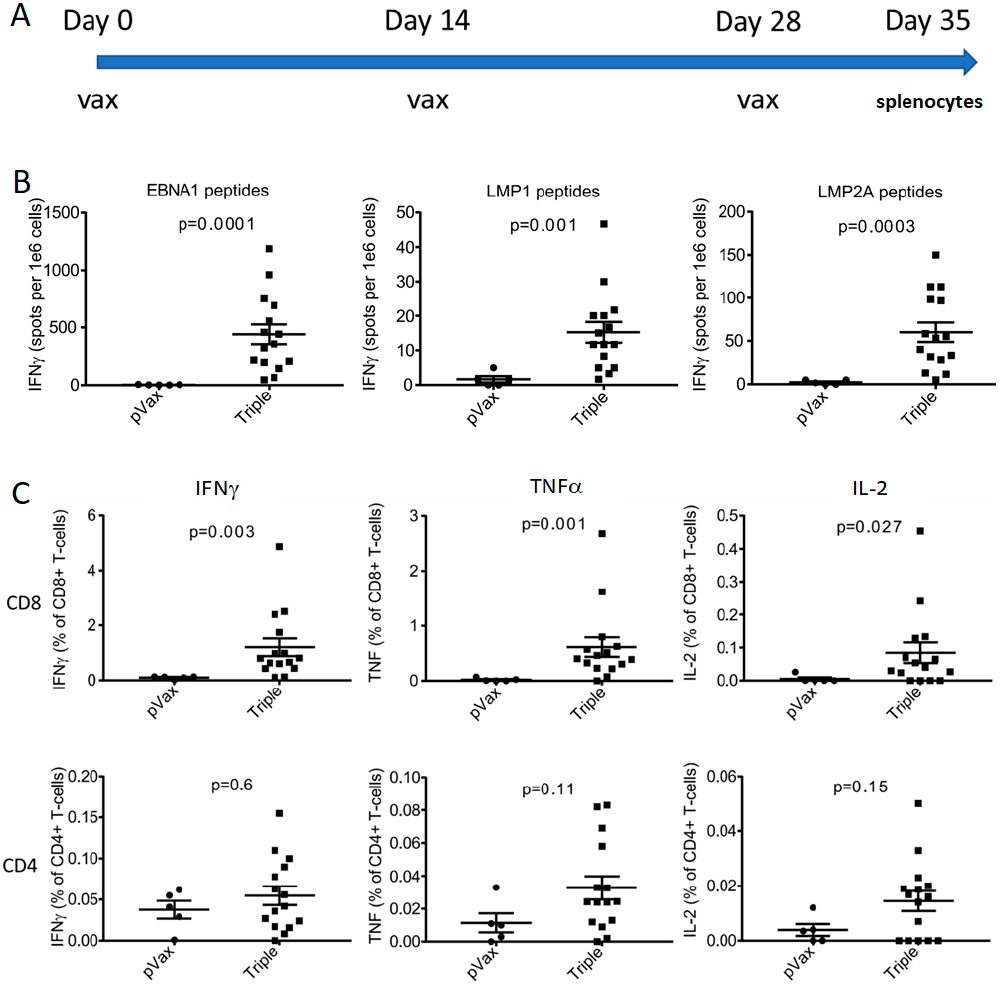
Figure 3. Cellular responses produced by combination vaccine in outbred CD-1 mice. ( A )